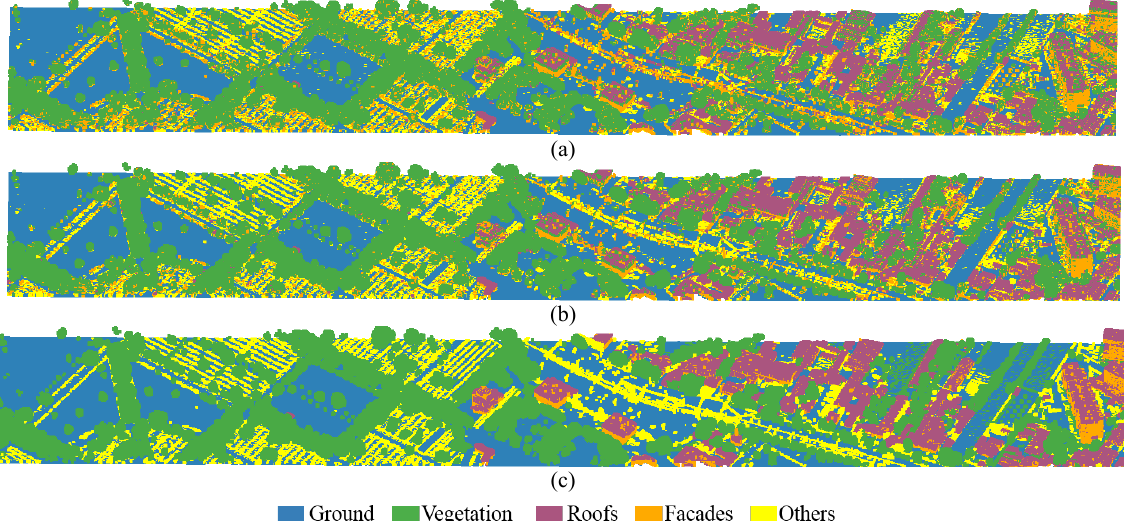
Figure 1. The classification results. (a) using the initial training dataset; (b) using the extended training dataset; (c) the reference labelled data.